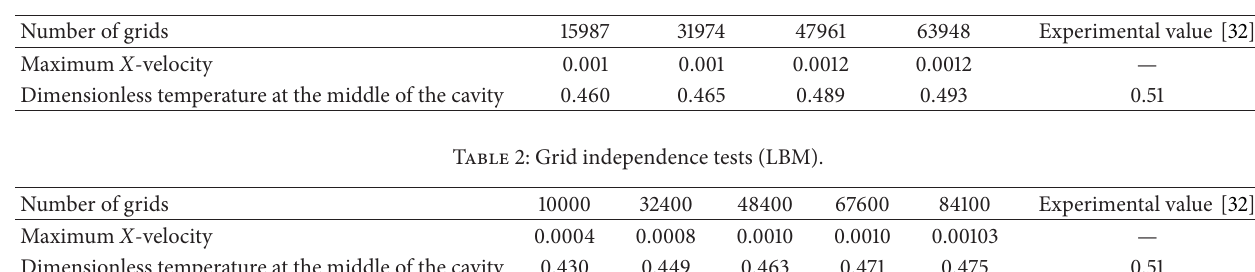
Table 1: Grid independence tests (FVM and QUICK/SIMPLEC).